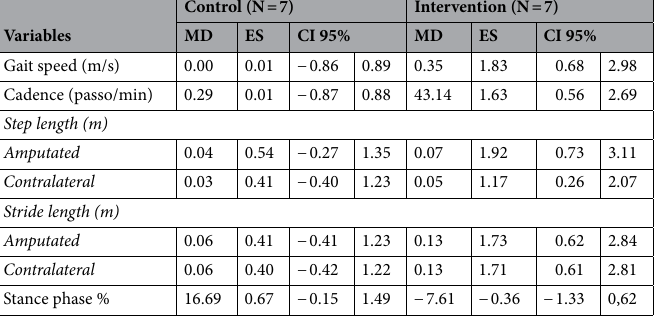
Table 8. Analysis of the magnitude of the intervention effects on temporal-spatial parameters of gait, in each amputee group. MD: Mean difference; ES: Effect size; 95% CI: 95% confidence interval.